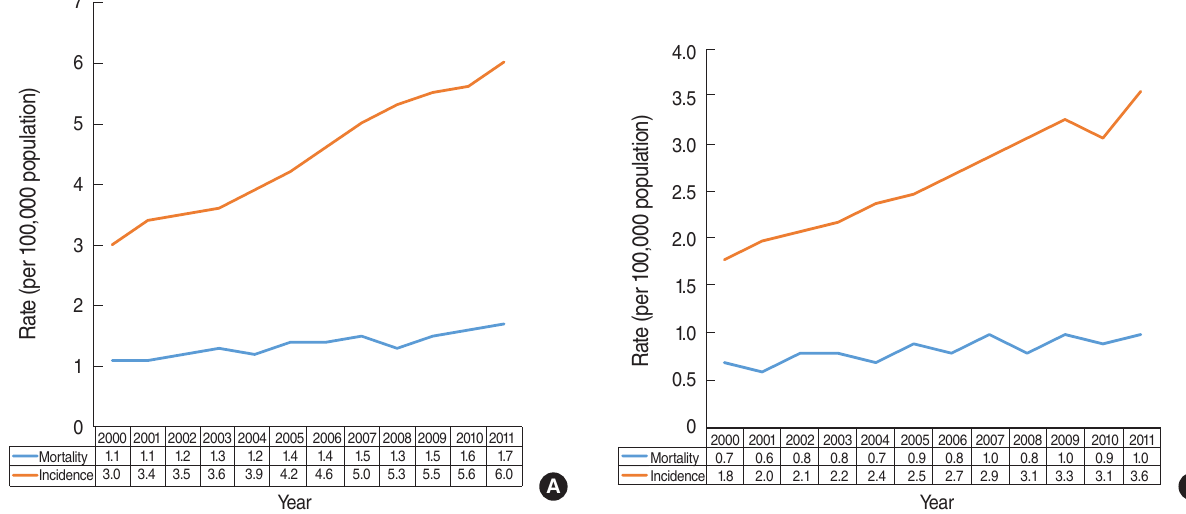
Figure 2. Age-adjusted incidence and mortality of kidney cancer between 2000 and 2011 in (A) all Koreans and (B) in Korean women. Figure 1. Prostate cancer in Korean men. (A) Age-adjusted incidence and mortality between 2000 and 2011. (B) Age-adjusted incidence in 2001, 2003, 2005, 2007, 2009, and 2011 by age group. Meanwhile, one of epidemiological characteristics of kidney cancer is that it is twice as common in males compared with fe- males [16]. Figure 2B presents the pattern of increase for inci- dence and mortality in females. Over the same time-period, the rate of increase for incidence was 2.2 times (=2/0.9) higher than mortality for males, and 6.0 times (=1.8/0.3) higher for females. Given that thyroid cancer, as detected by neck ultrasound, is far higher in females [6], future research will be necessary to inves- tigate whether the larger discrepancy shown for females with kidney cancer is related to the diffusion of ultrasound.